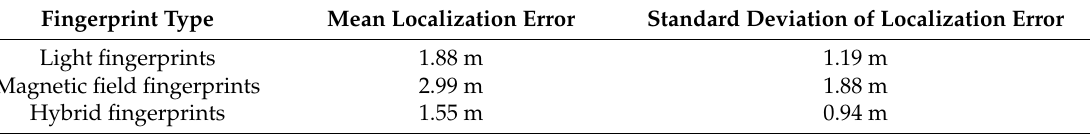
Table 4. The localization error in the open-plan area using different fingerprints.